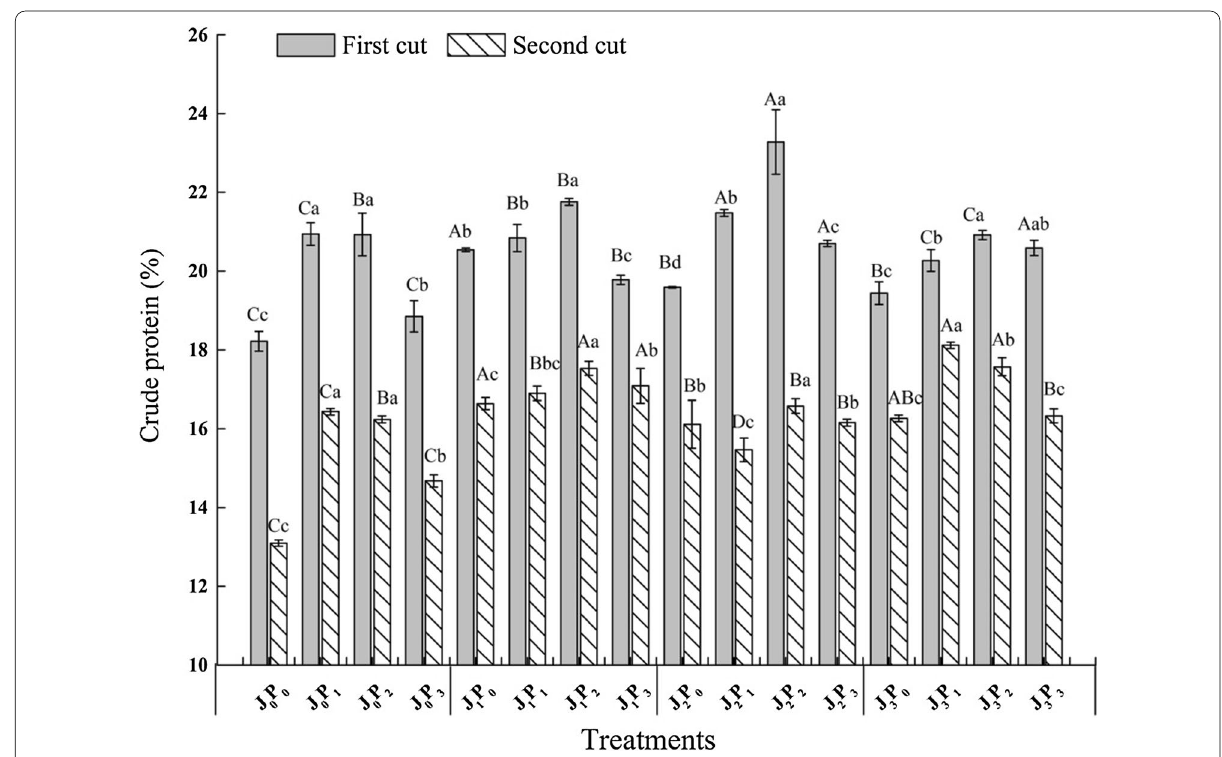
Fig. 3 Crude protein content of alfalfa inoculated with AMF and PSB under different phosphorus application